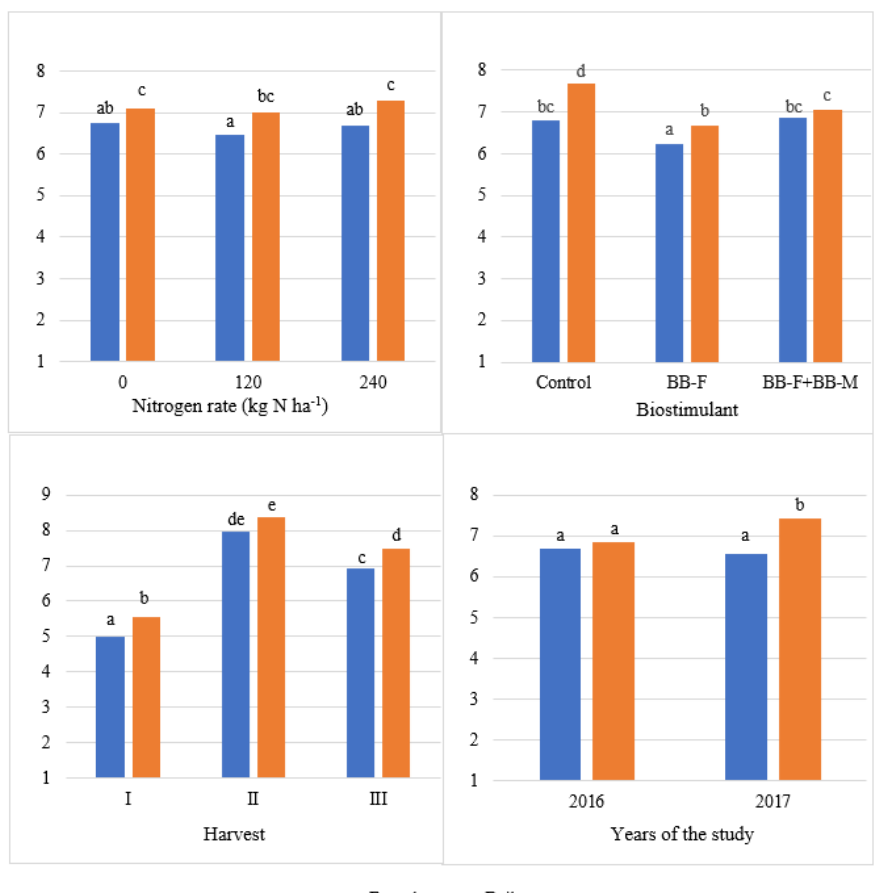
Figure 6. Relationships between the content of calcium (g kg − 1 DM) in the post-harvest biomass of the analyzed perennial ryegrass cultivars vs. nitrogen rate, biostimulant and years of the study (the same letter do not differ significantly at p < 0.05 in Tukey’s HSD test).